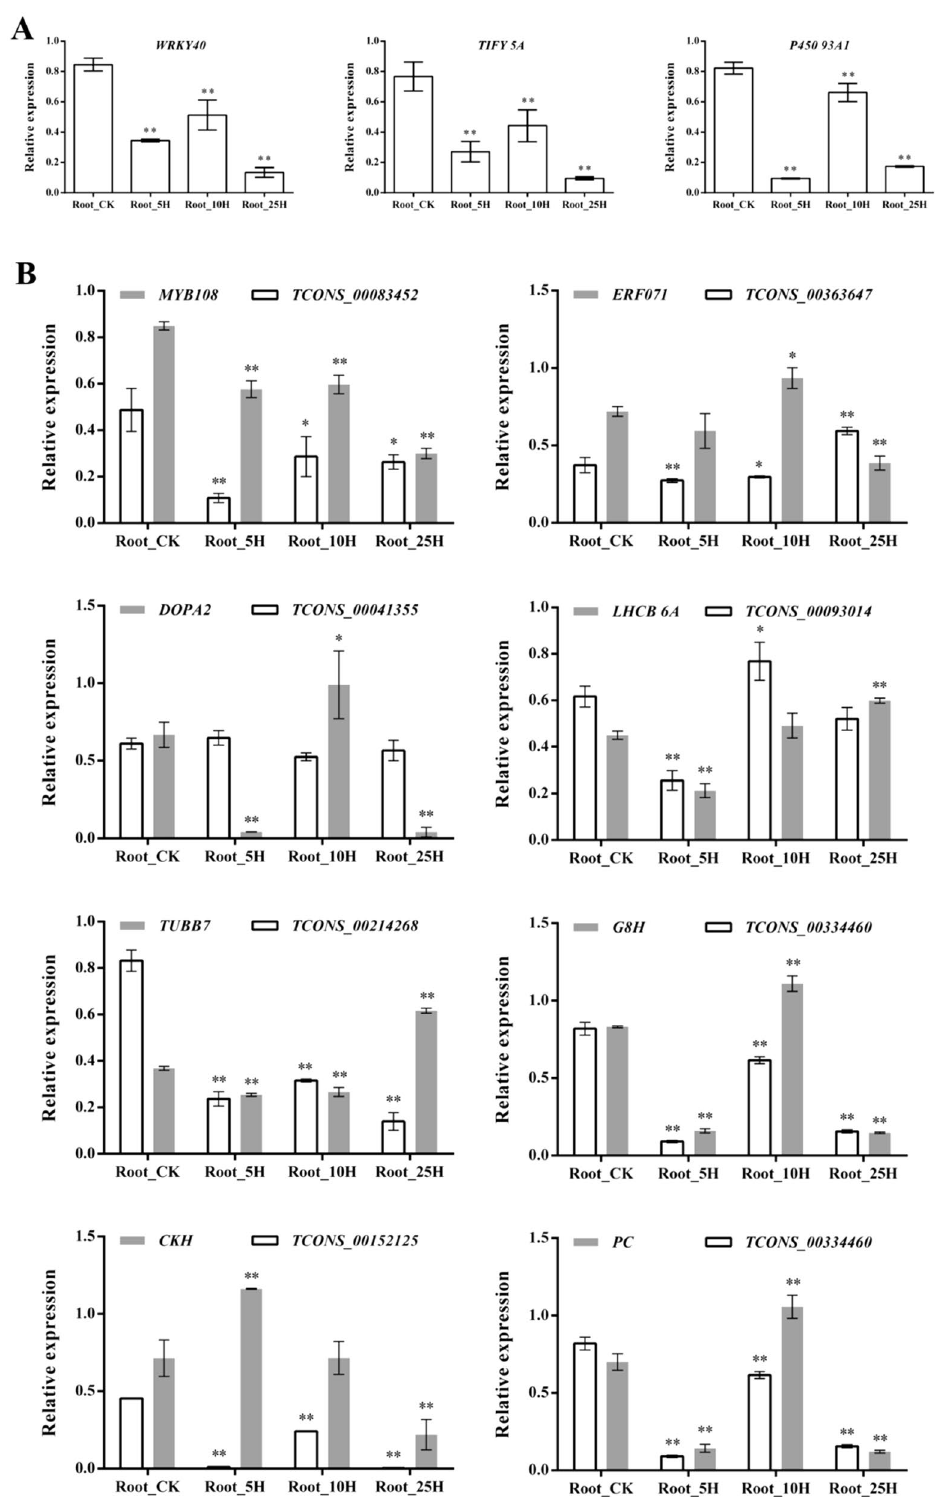
Figure 6. Quantitative real time PCR results of selected differentially expressed genes (DEGs), and long noncoding RNAs (DELs) and their predicted target genes (DETs). ( A ) expression of DEGs without corresponding lncRNAs; ( B ) expression of DELs and their corresponding DETs. P450 93A1 : Cytochrome P450 93A1 , ERF071 : Ethylene-responsive transcription factor ERF071 , DOPA2 : Tyrosine/DOPA decarboxylase 2 ; LHCB6A : light harvesting chlorophyll a–b binding protein 6A , TUBB7 : tubulin beta-7 chain like gene , G8H : geraniol 8-hydroxylase-like , CTH : cytokinin hydroxylase-like , PC : Plastocyanin . Columns marked with ‘*’ or ‘**’ indicate significant or very significant difference with the Root_CK group,